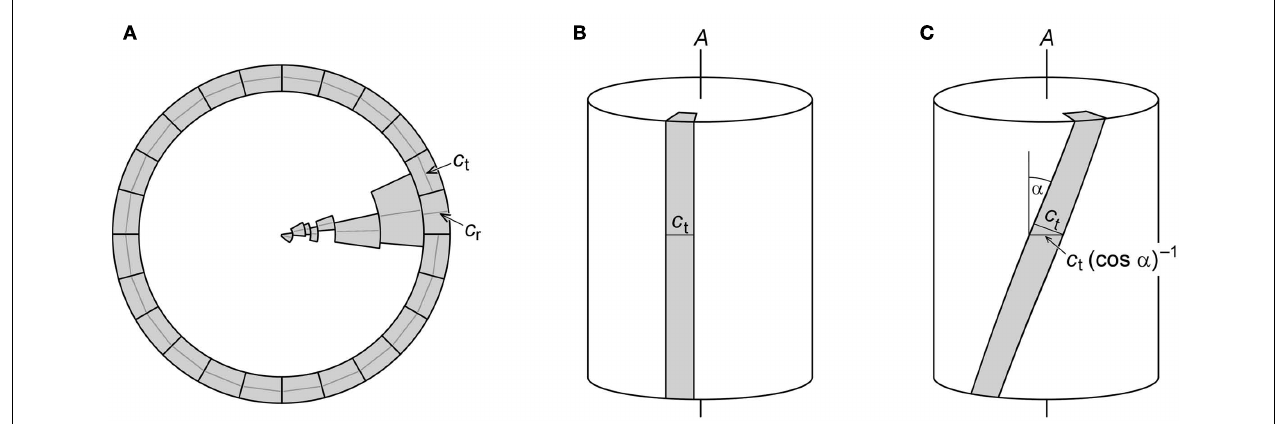
of a cell layer provides the central circumference of that layer, while the sum of the c r of all cell layers equals the organ radius. (B) If the longitudinal axis of a cell is parallel with the organ axis A , the c t measured on an organ cross-section represents the actual c t of the cell. (C) If a cell file is tilted with pitch angle α against A , the apparent c t measured on an organ cross-section overestimates the true c t by the factor (cos α ) − 1